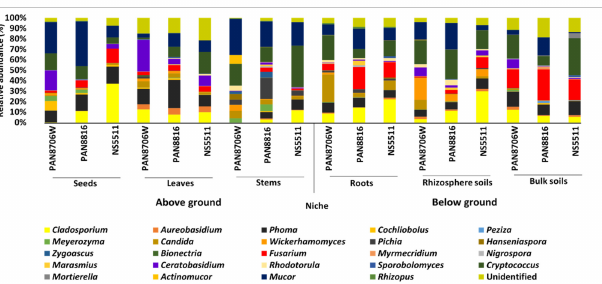
Figure 2. Relative abundance of fungal communities in the different sorghum cultivars at genus level ( ≥